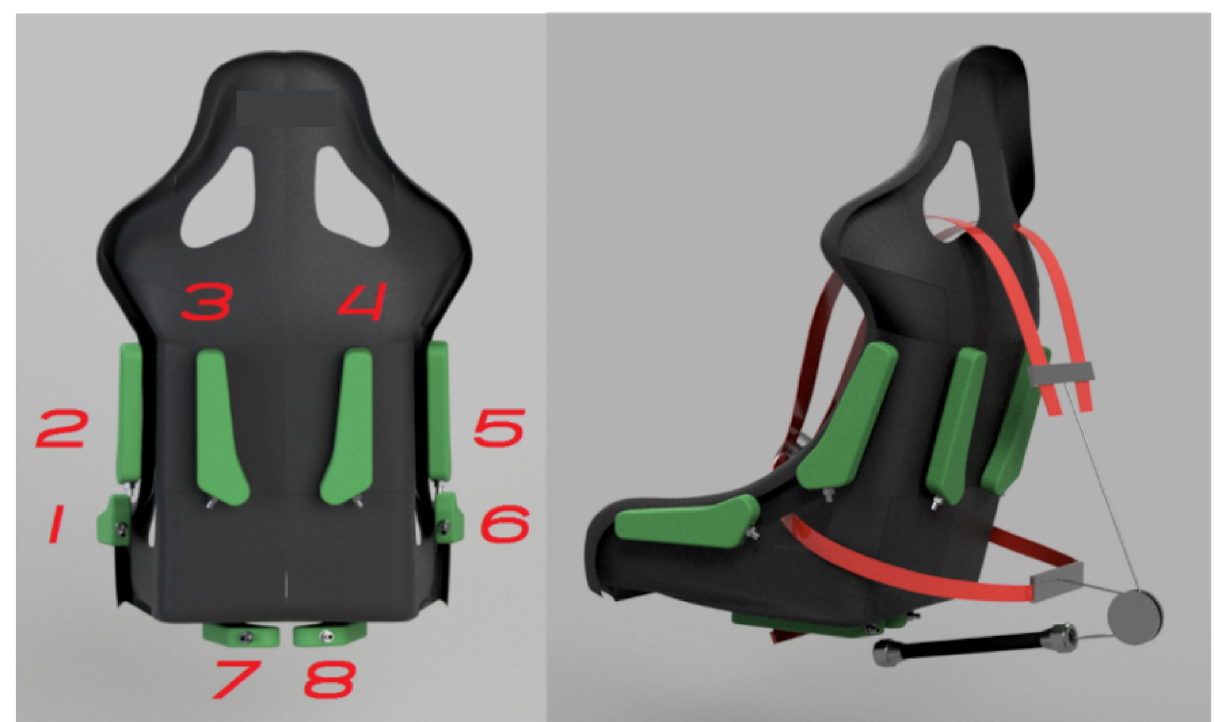
Fig 2. ASB system: The left picture shows the position of the bladders, whereas the picture on the right shows the belts tensioned by a muscle.